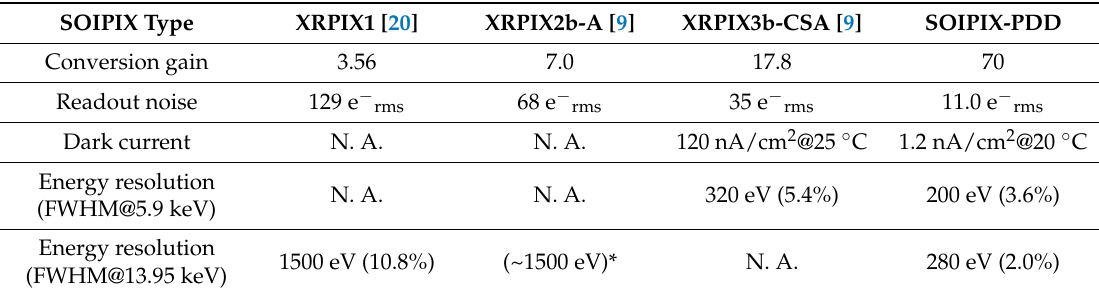
Table 2. Comparison with the conventional SOIPIX (XRPIX series) and SOIPIX-PDD.